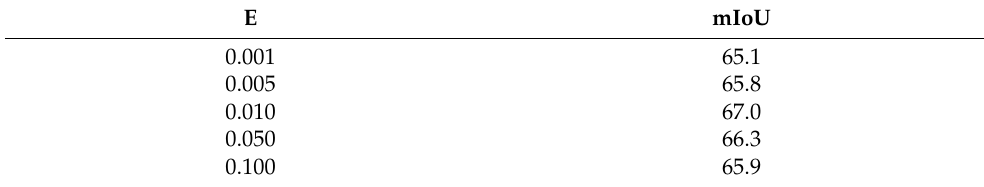
Table 2. Comparison of different settings in the Sample-Selection Algorithm.